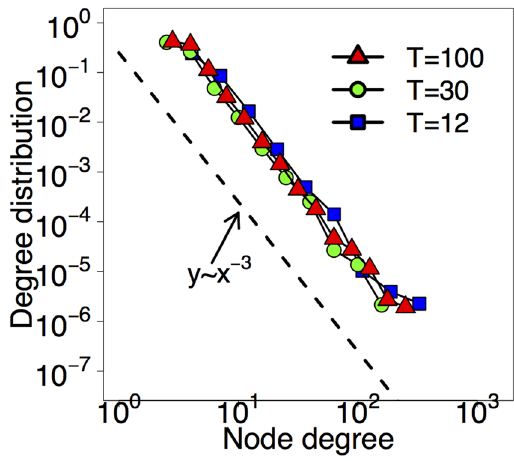
Figure 5. The degree distributions of our simulated networks. The plot confirms that the choice of T does not effect the degree distribution, which is a power-law with γ =